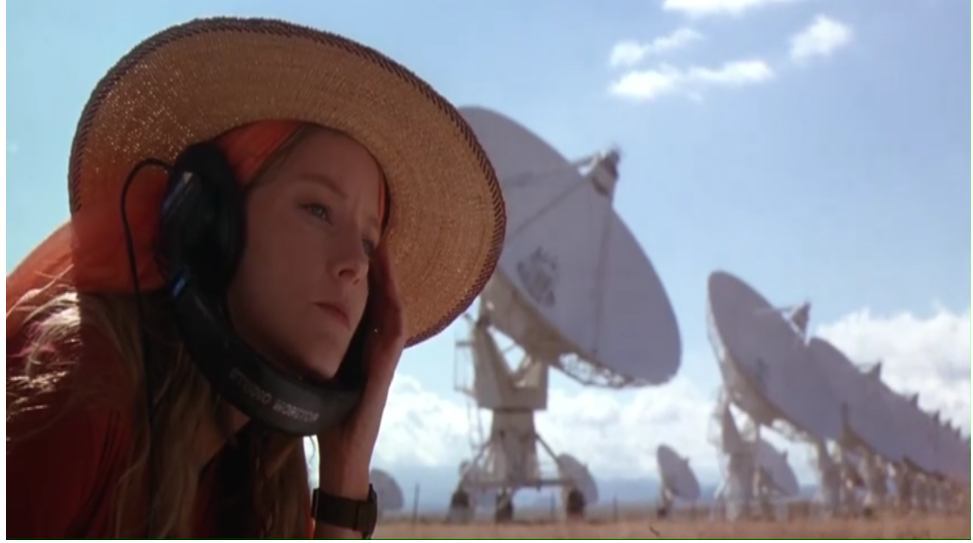
Figure 1: Contact . Ellie becomes aligned with the radio